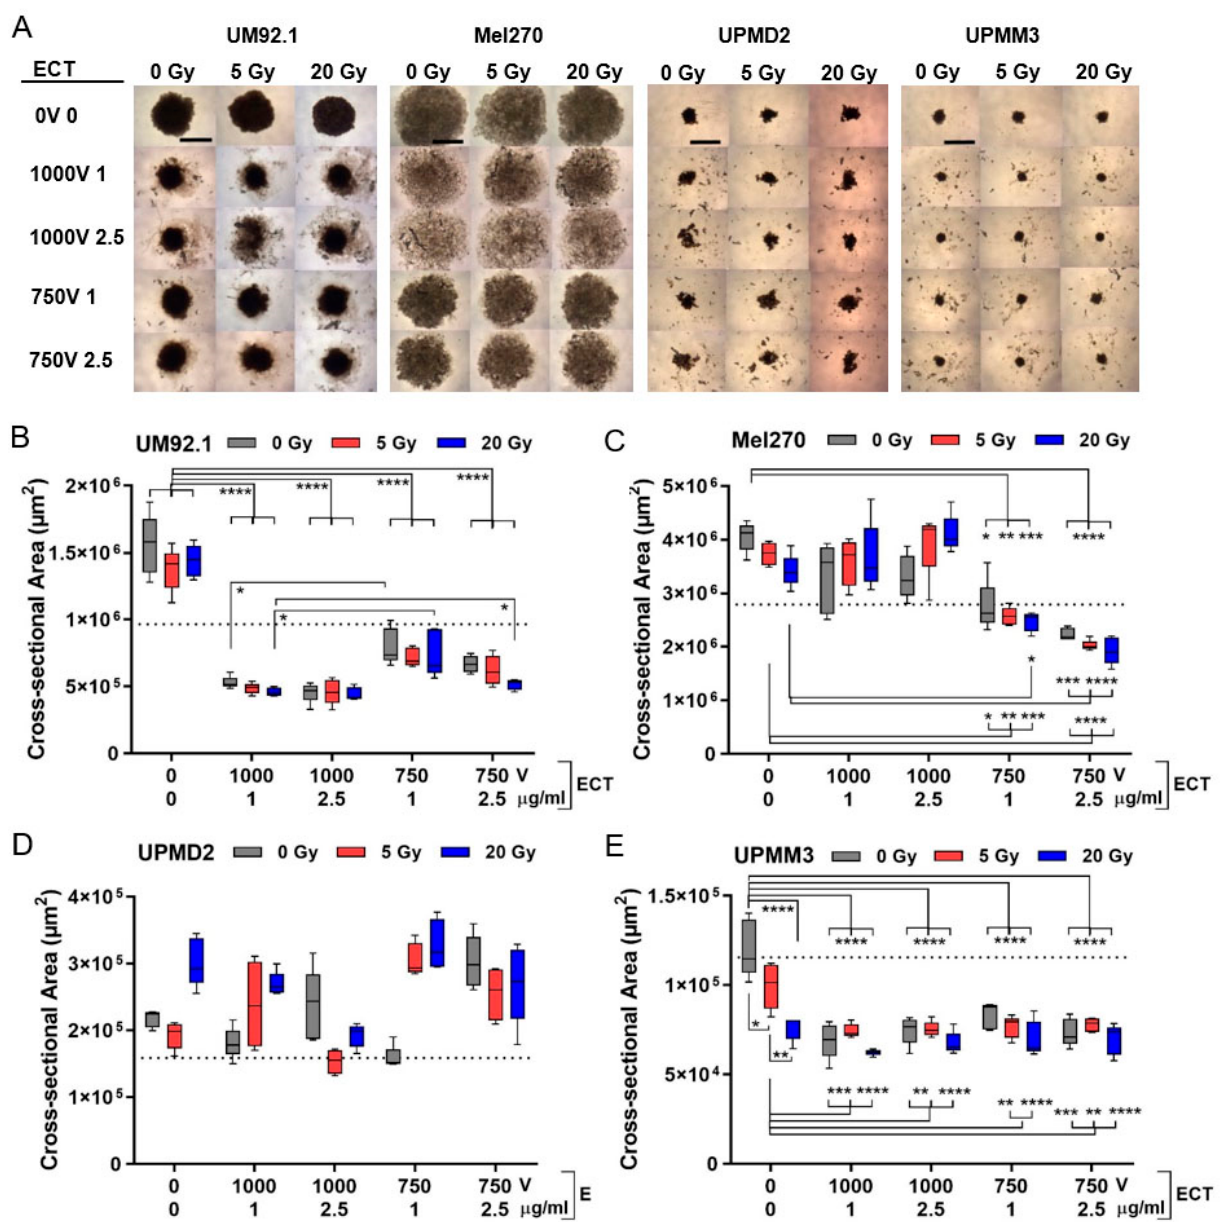
Figure 2. 3D tumor spheroid growth after combination treatment. At day 4, spheroids were either irradiated (dose 5 or 20 Gy) or treated with ECT (electroporated 1000 V or 750 V in the presence of 1 µg/mL or 2.5 µg/mL bleomycin) or spheroids were irradiated followed by ECT. Five days after treatment (at day 12) the effect on spheroid growth was determined. ( A ) Representative spheroids are shown (4 × magnification; scale bar of figure 2A represents 1000 µm). ( B – E ) Corresponding cross-sectional area of spheroids ( n = 5 each condition). Additionally, the mean cross-sectional area of spheroids before treatment at day 7 is shown (dotted line; UM92.1: 9.7 × 10 5 µm 2 ; Mel270: 2.8 × 10 6 µm 2 ; UPMD2: 1.6 × 10 5 µm 2 ; UPMM3: 1.2 × 10 5 µm 2 ). A statistical analysis was performed using a two-way ANOVA and Tukey’s multiple comparisons test; * p < 0.05, ** p < 0.01, *** p < 0.005, **** p < 0.001.